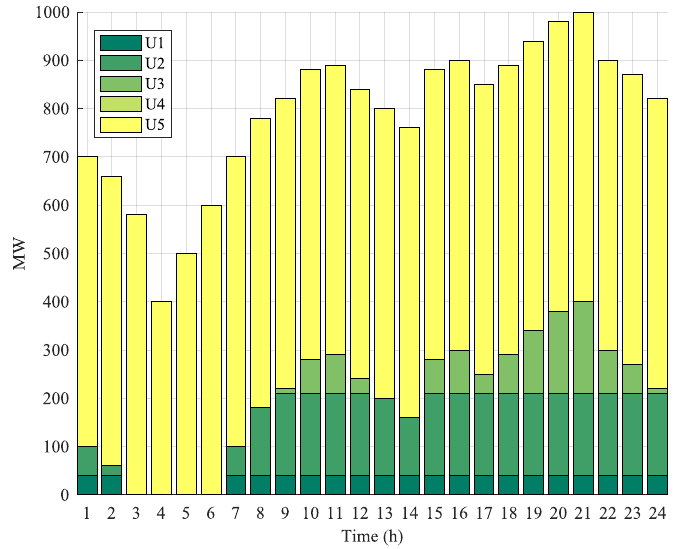
Figure 2. Units’ output power without transmission congestion.